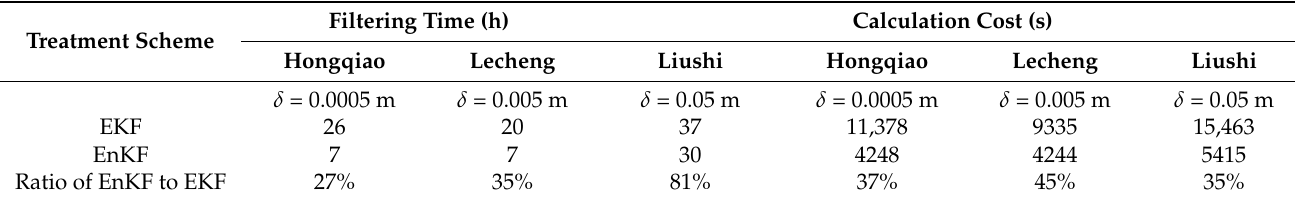
Table 9. Impact of observation noise level on data assimilation results based on EKF and